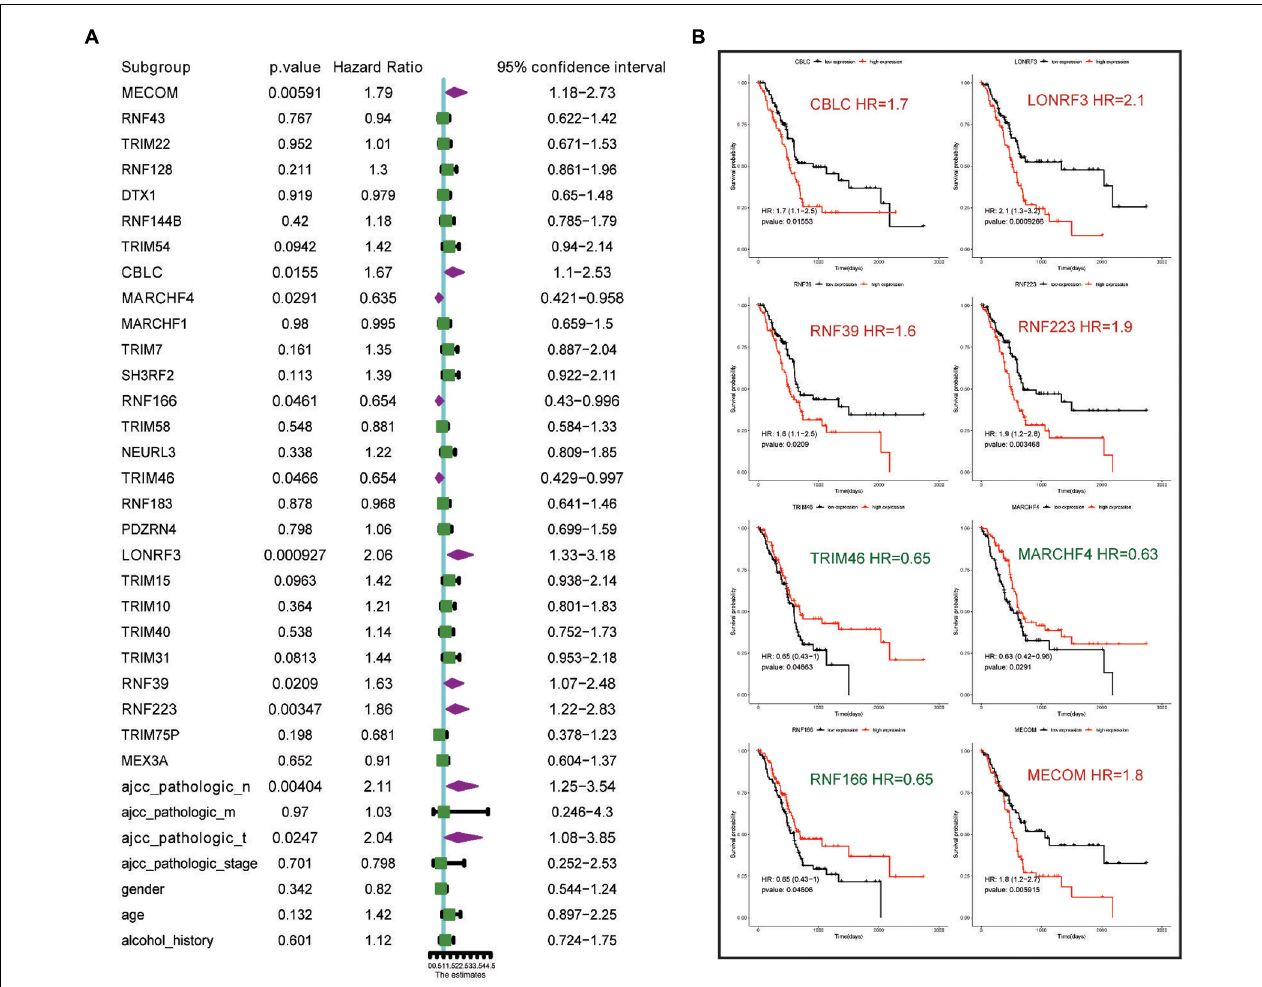
FIGURE 2 | Univariate analysis highlights eight genes and clinical parameters with overall prognostic significance. (A) Univariate analysis of the 27 DEGs with prognostic significance in the TCGA PAAD dataset. (B) Kaplan–Meier survival analysis showing the HR of eight genes’ expression with OS rate in TCGA PAAD dataset. Favorable and unfavorable markers are labeled in green and red,